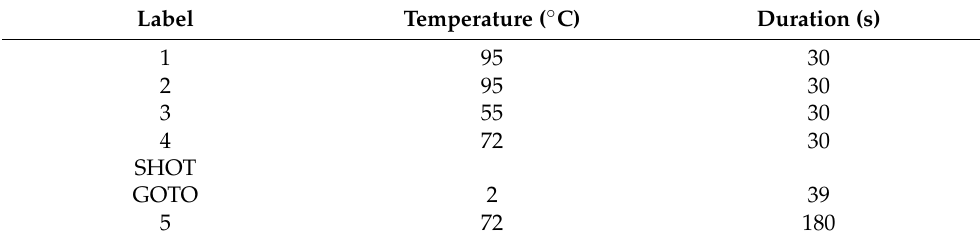
Table 2. PCR protocol example.